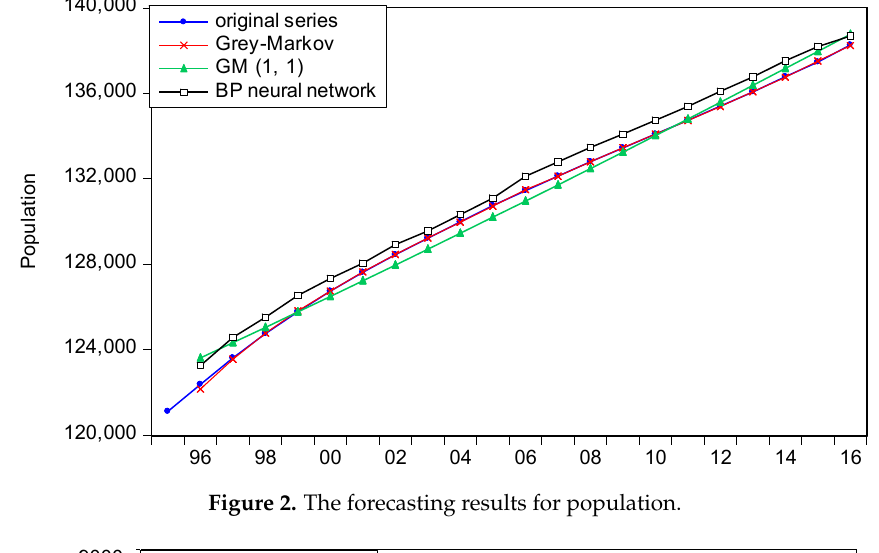
Table 7. The MAPE values of forecasting results for the driving factors. Variable